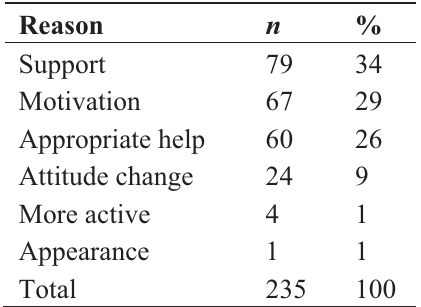
Table 10. Number and percentage of reasons given by patients for feeling encouraged to lead a healthier lifestyle.